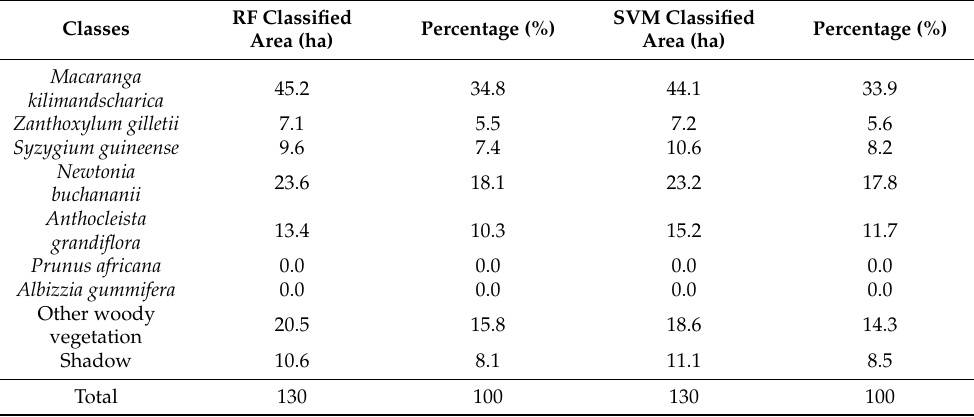
Table 6. Area coverage in hectares and percentage of the classes using RF and SVM classifiers.